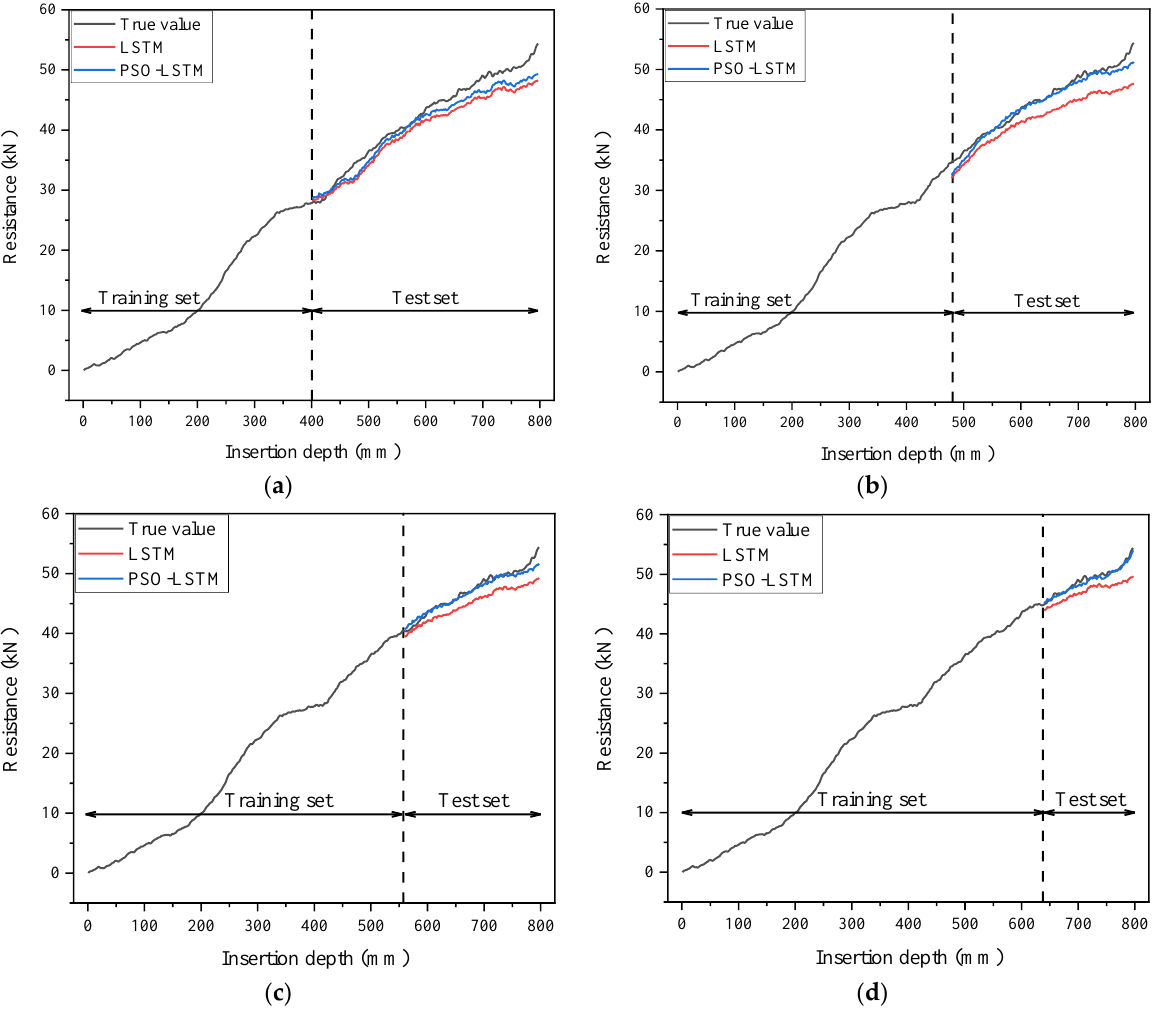
Figure 21. Sand samples with an insertion depth of 800 mm. ( a ) The training set proportion of 50%; ( b ) The training set proportion of 60%; ( c ) The training set proportion of 70%; ( d ) The training set proportion of 80%. Table 9. PSO-LSTM optimization parameters for the sand sample